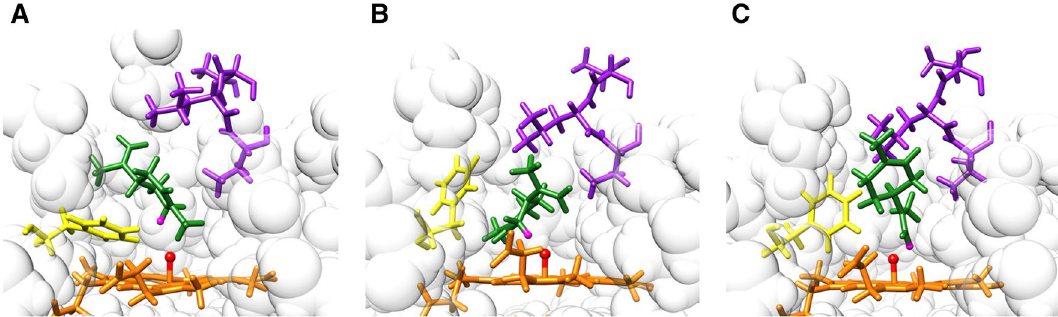
Figure 3. Conformational examples of docking poses in which H6b [corresponding to trans -carveol ( 12 ), ( A )], H3a [corresponding to cis -isopiperitenol ( 6 ), ( B )], and H9b [the largest component of the byproduct docking pose group, ( C )] of ( S )-(−)-limonene contact the O atom bound to the Fe atom in heme. A view of the active site from the pocket entrance side. The heme and ( S )-(−)-limonene are represented by orange and green sticks, respectively. The active site, heme oxygen is a red ball. The modification sites corresponding to H6b, H3a, and H9b are taken as magenta spheres. The orientation of the side chain ring of F87 (yellow stick) and the β-turn of T436-T438 (purple stick) changed depending on the modification sites on the